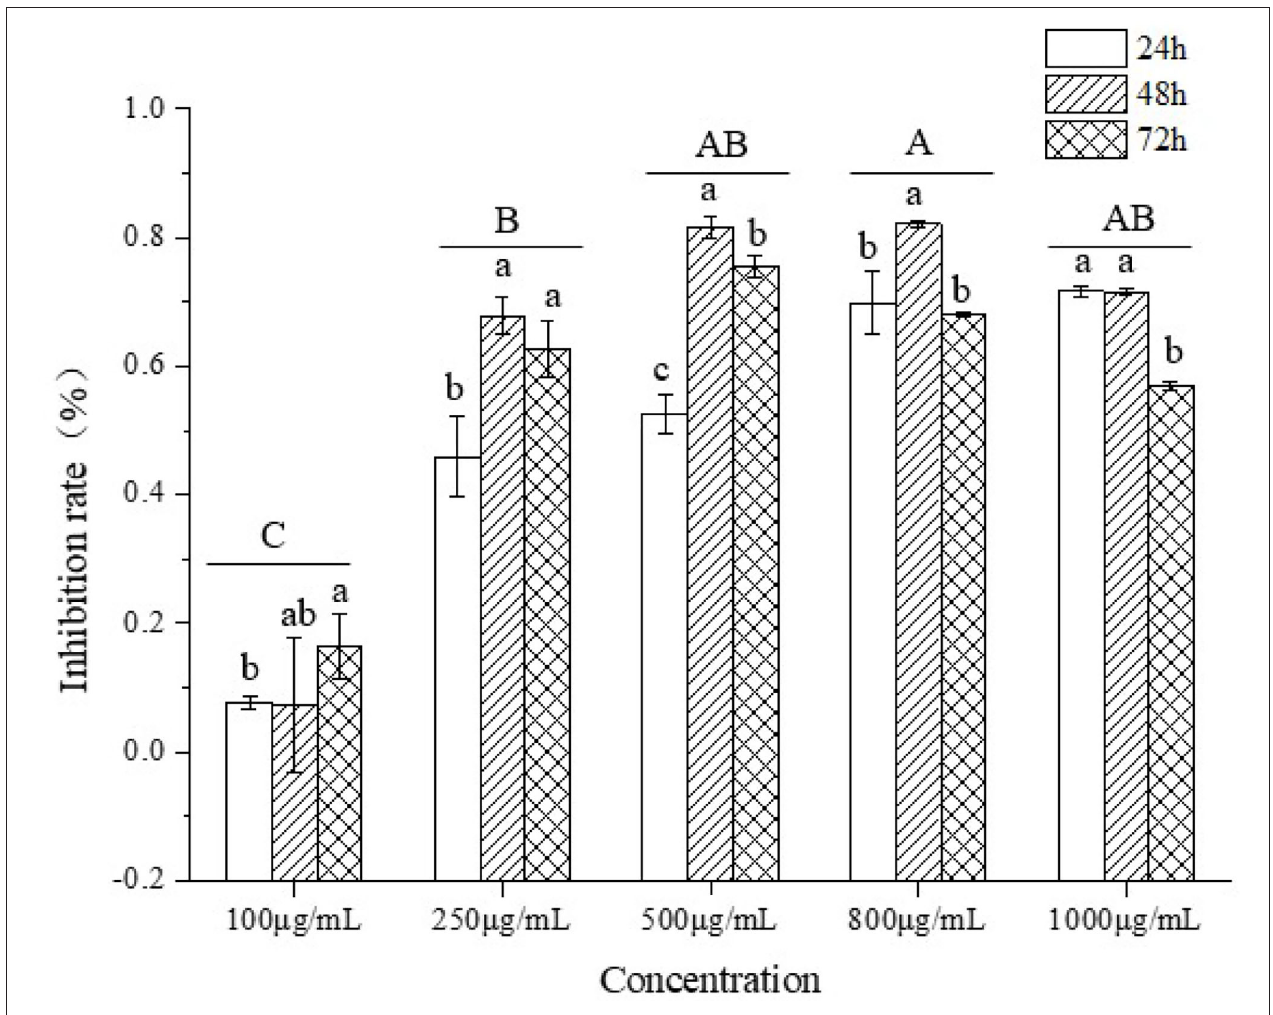
FIGURE 6 | The inhibitory effect on HT-29 cell